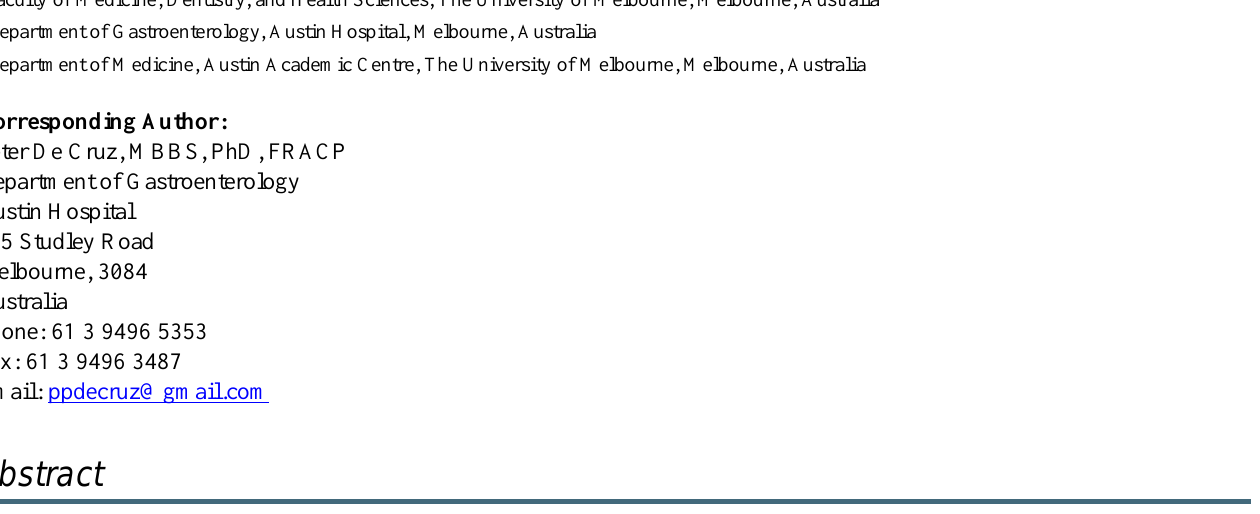
IBD; apps; eHealth; smartphone;